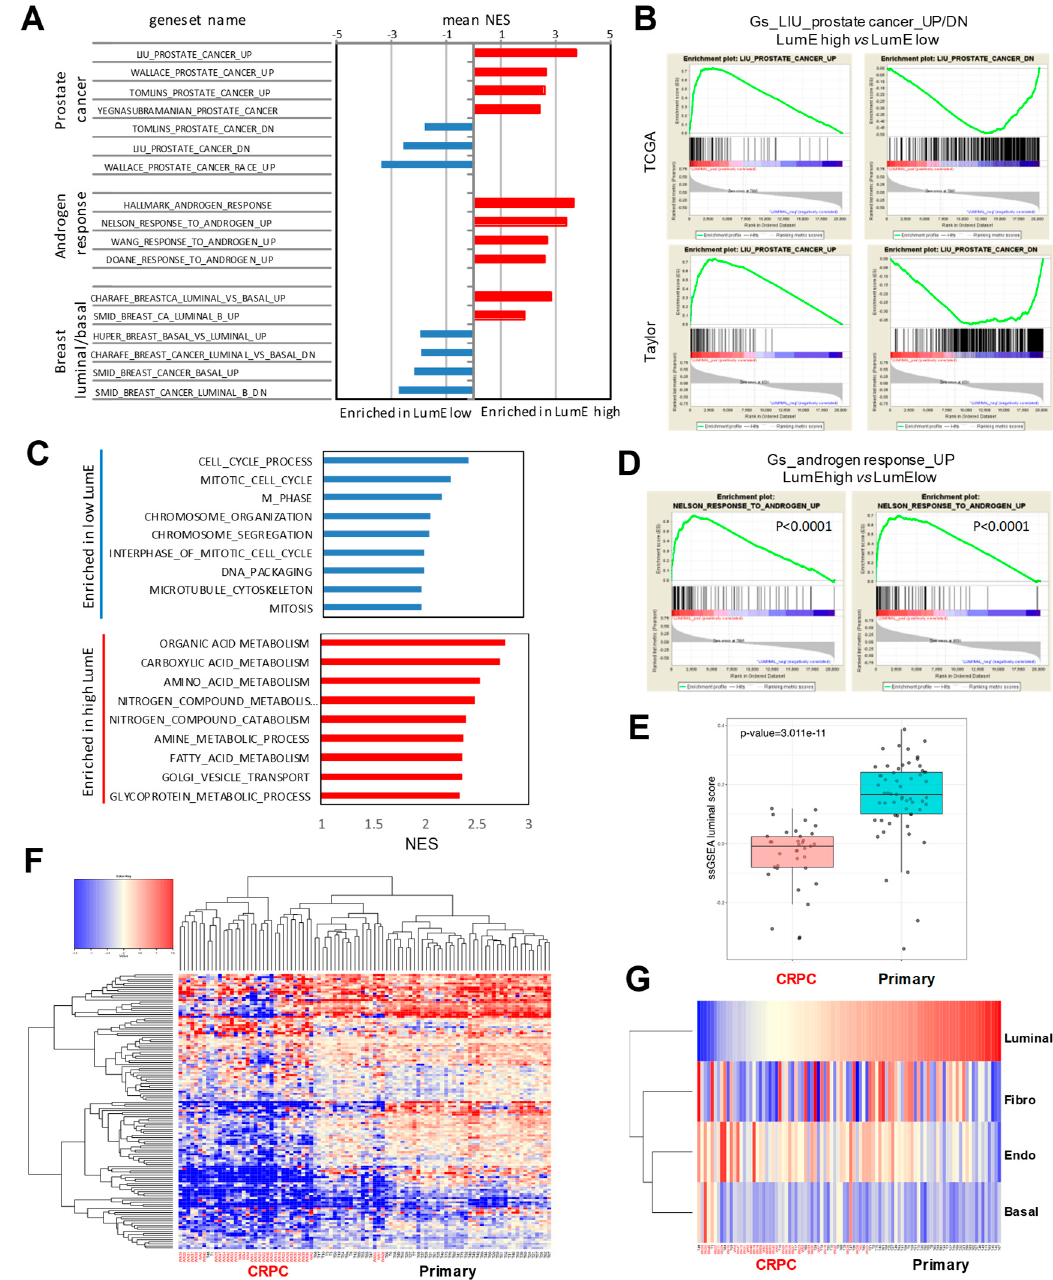
Figure 3. Luminal metagene score is associated with androgen receptor signaling and is attenuated in castration-resistant prostate tumors. ( A ) Gene set enrichment analysis (GSEA) in tumors with higher or lower LumE scores in The Cancer Genome Atlas (TCGA) and Taylor datasets. NES, normalized enriched scores. ( B ) GSEA plots with prostate-specific genesets showing enrichment in tumors with high LumE scores. ( C ) GSEA with KEGG pathways showing enrichment in tumors in TCGA dataset with either higher or lower LumE scores. ( D ) GSEA plots with androgen upregulated genes showing enrichment in high LumE tumors in Taylor (left) and TCGA (right) datasets. ( E ) Luminal scores in primary tumors versus castration-resistant prostate cancers (CRPCs) in the Grasso dataset. Luminal scores are significantly lower in CRPCs. ( F ) Unsupervised hierarchical clustering analysis of primary tumors and CRPCs based on the luminal metagene. Note the robust clusterization of CRPCs based on the attenuated luminal signature. ( G ) Distribution of metagene scores in primary tumors and CRPCs. Samples are ordered by increasing LumE scores. Note the prevalently lower LumE scores in CRPCs compared to primary tumors. For GSEA threshold of significance is FDR < 0.01.